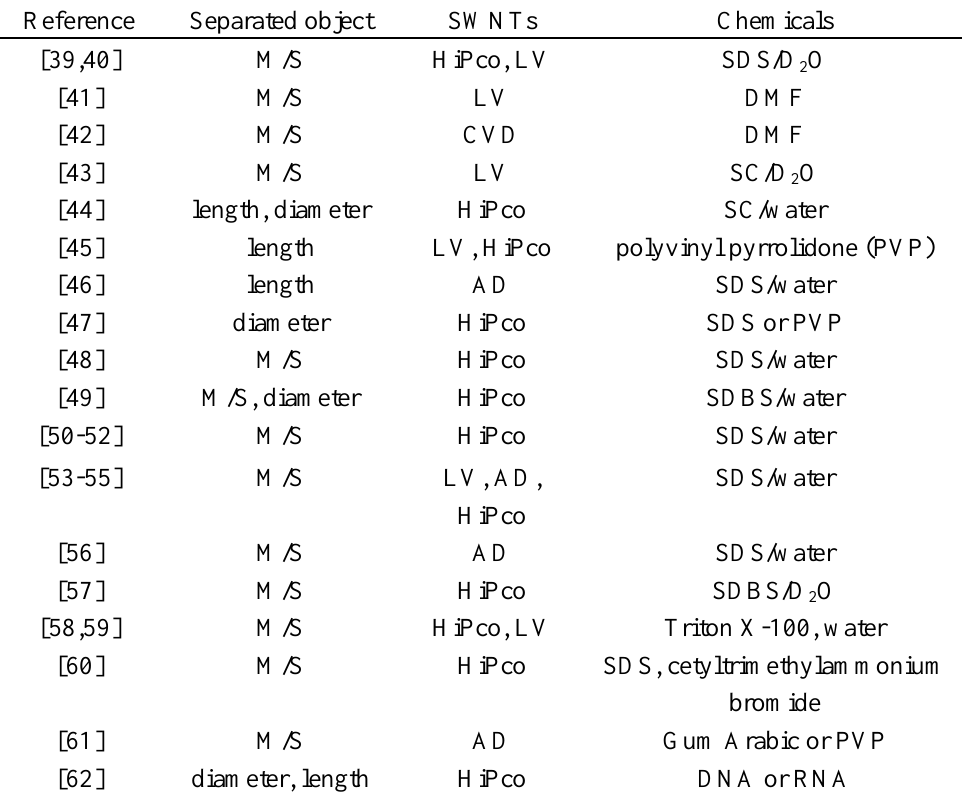
Table 1. Separation of SWNTs by